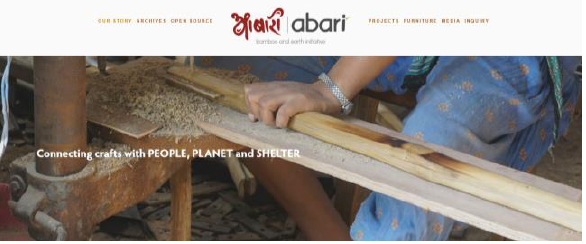
Figure 4. Details of Abari Foundation working